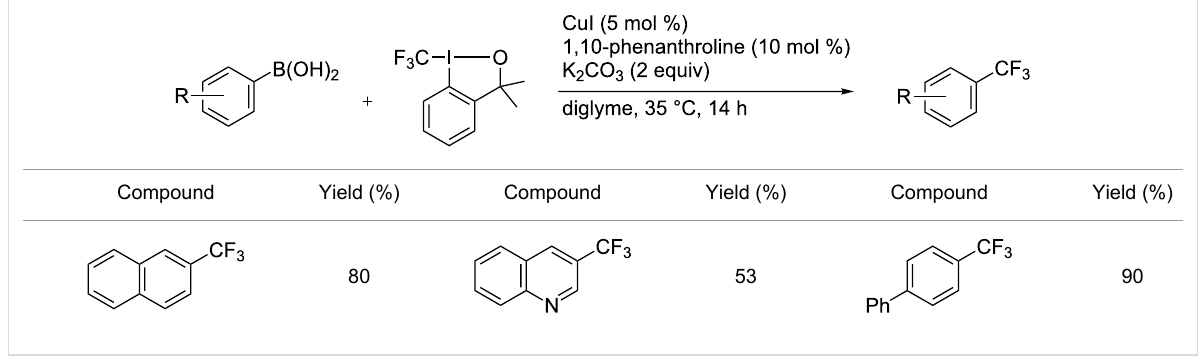
Table 24: Cu-catalyzed trifluoromethylation of aryl- and alkenylboronic acids employing Togni's hypervalent iodine reagent